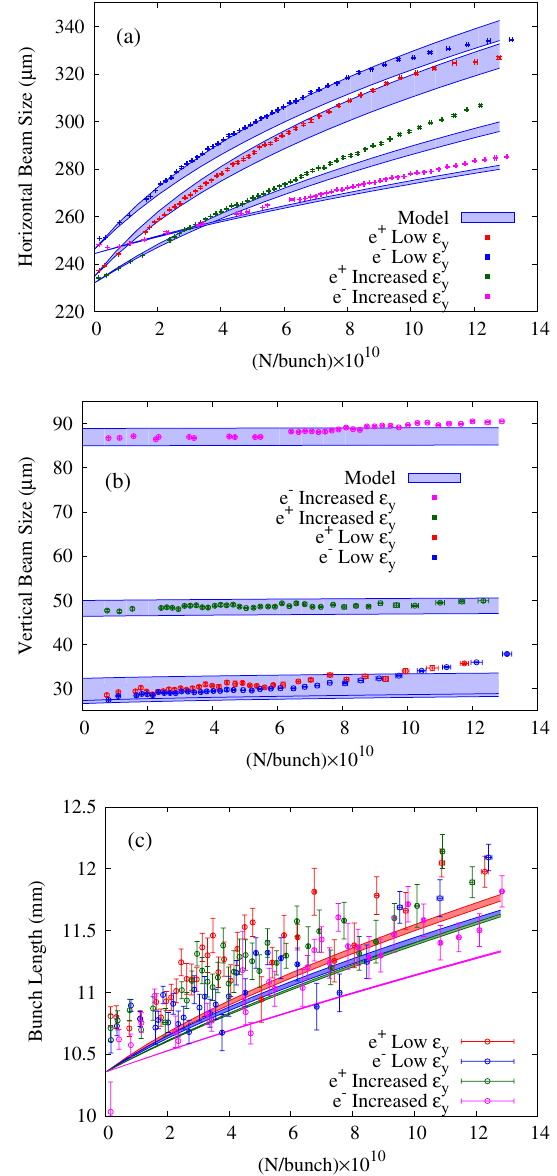
FIG. 14. Aggregated and (c) longitudinal data comparing e þ and e (cid:1) in minimum emittance conditions and conditions where the zero current vertical emittance was blown up using closed coupling and dispersion bumps. 4.2 nm rad at zero current and 5.5 nm rad at 4 : 8 (cid:3) 10 10 particles = bunch . The vertical emittances that bound the data are 172 and 188 pm.